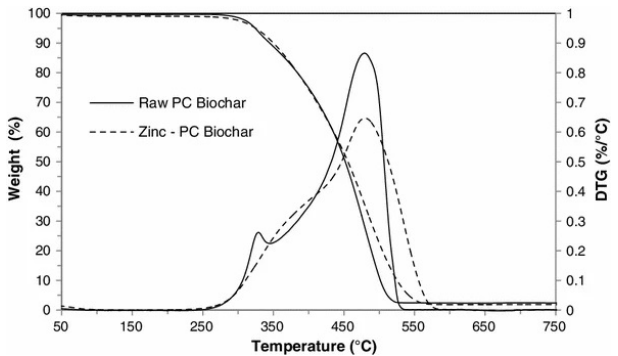
Figure 13. TG curves of original pine cone biochar and Zn-modified pine cone biochar [116]. Reprinted with permission from N. Van Vinh et al. (2015). Copyright 2015, Springer.